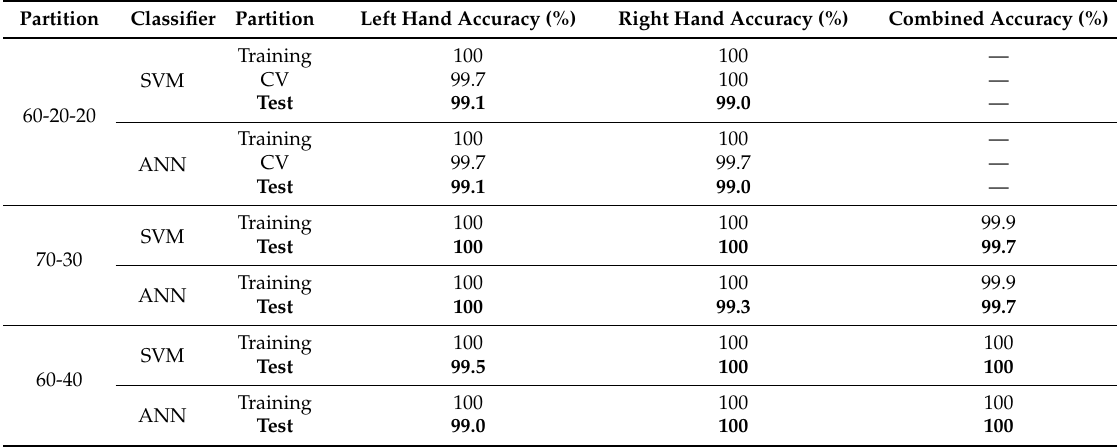
Table 6. Training, validation and test set accuracies (Generalized, after